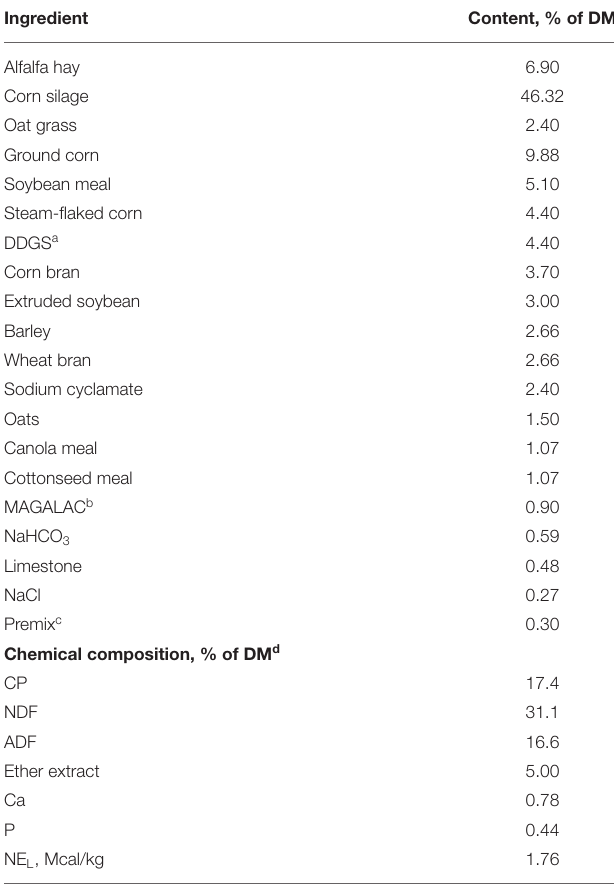
TABLE 1 | Ingredients and nutrient composition of the basal